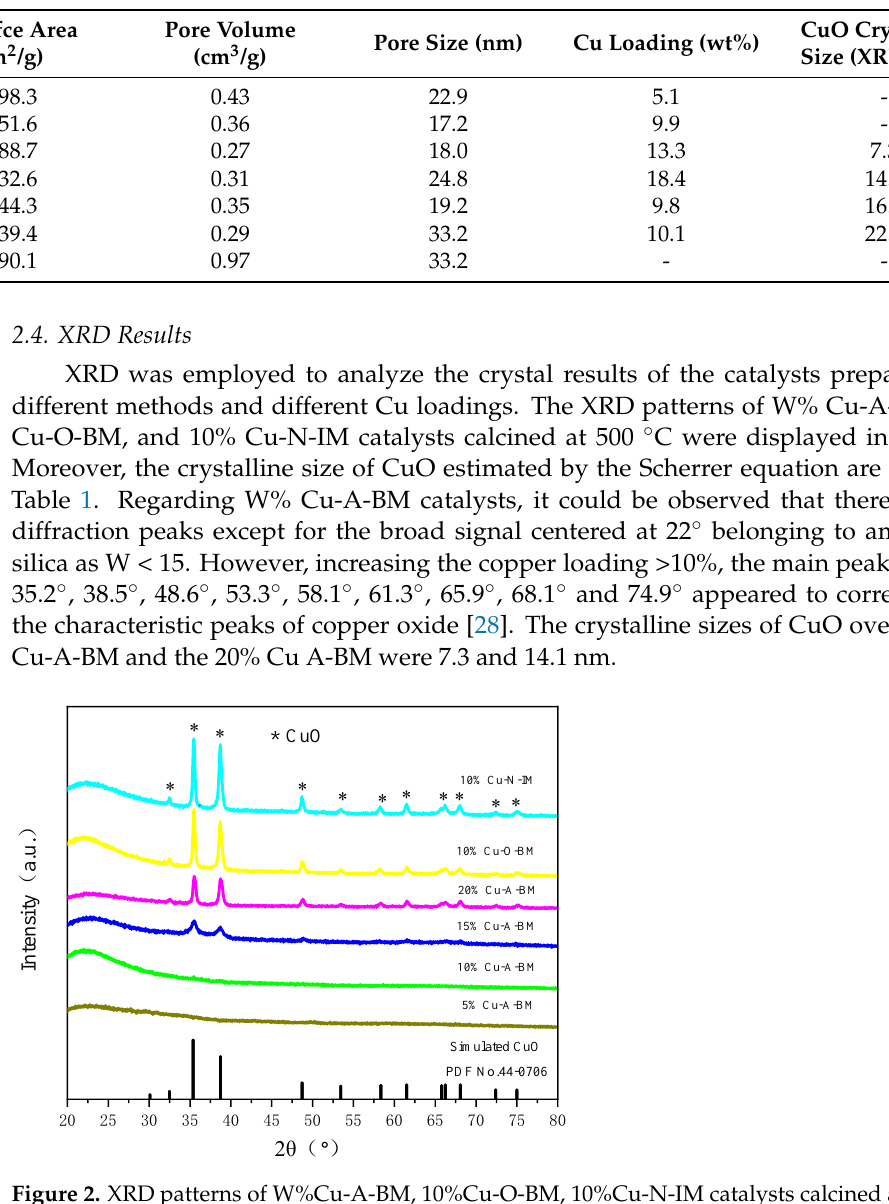
Figure 3. XRD patterns of 20%Cu-A-BM samples pretreated at different temperatures.